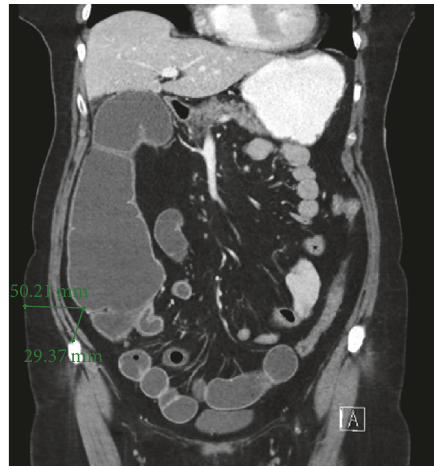
Figure 3: Coronal CT showing caecum measured from the anterior superior iliac spine and the lateral abdominal wall.